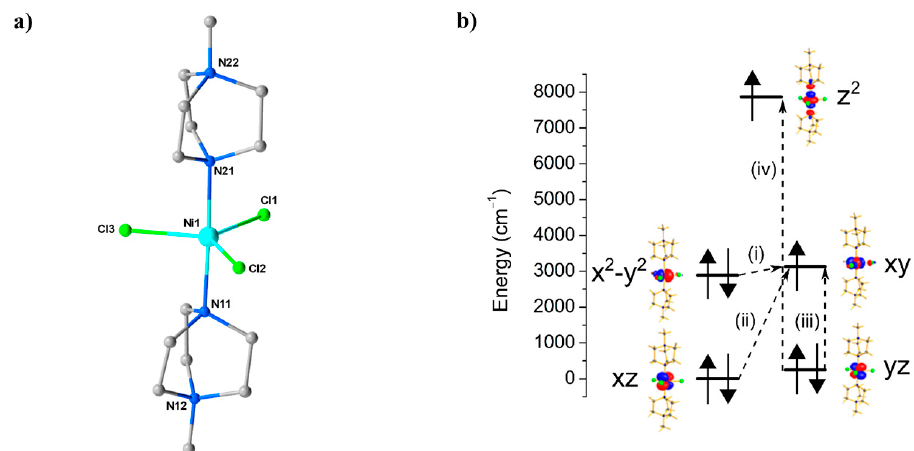
Figure 18. ( a ) The molecular structure of the cation of 13 . Colour code: Ni = cyan, N = blue, C = grey, Cl = green. H atoms and counterions are omitted for clarity. ( b ) NEVPT2-LFT computed d-orbital energies of the Ni II ion at ambient pressure along with the most significant excitations that contribute to the total D value: (i) − 488 cm − 1 ; (ii) +22 cm − 1 ; (iii) +19 cm − 1 ; (iv) +8 cm − 1 . Table 8. Selected distances (Å) and angles (°) in compound 13 as a function of pressure (GPa). P/GPa Ni1–N11